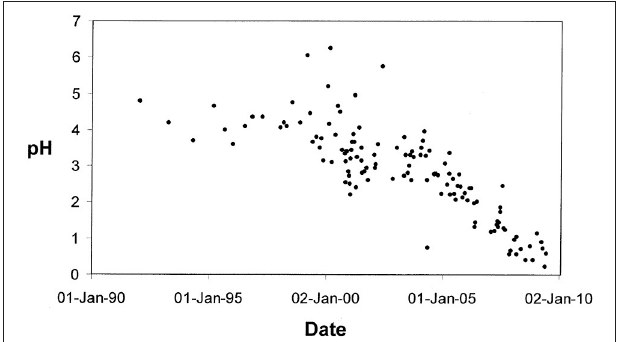
FIGURE 5 | Values of pH from West crater fumaroles at Turrialba, 1992–2009. Note the relatively stable and high values from 1992 until 2000, the gradual decline from 2000 to 2004, and the steep decline since then. Martini et al. (2010), Copyright 2010, with permission from